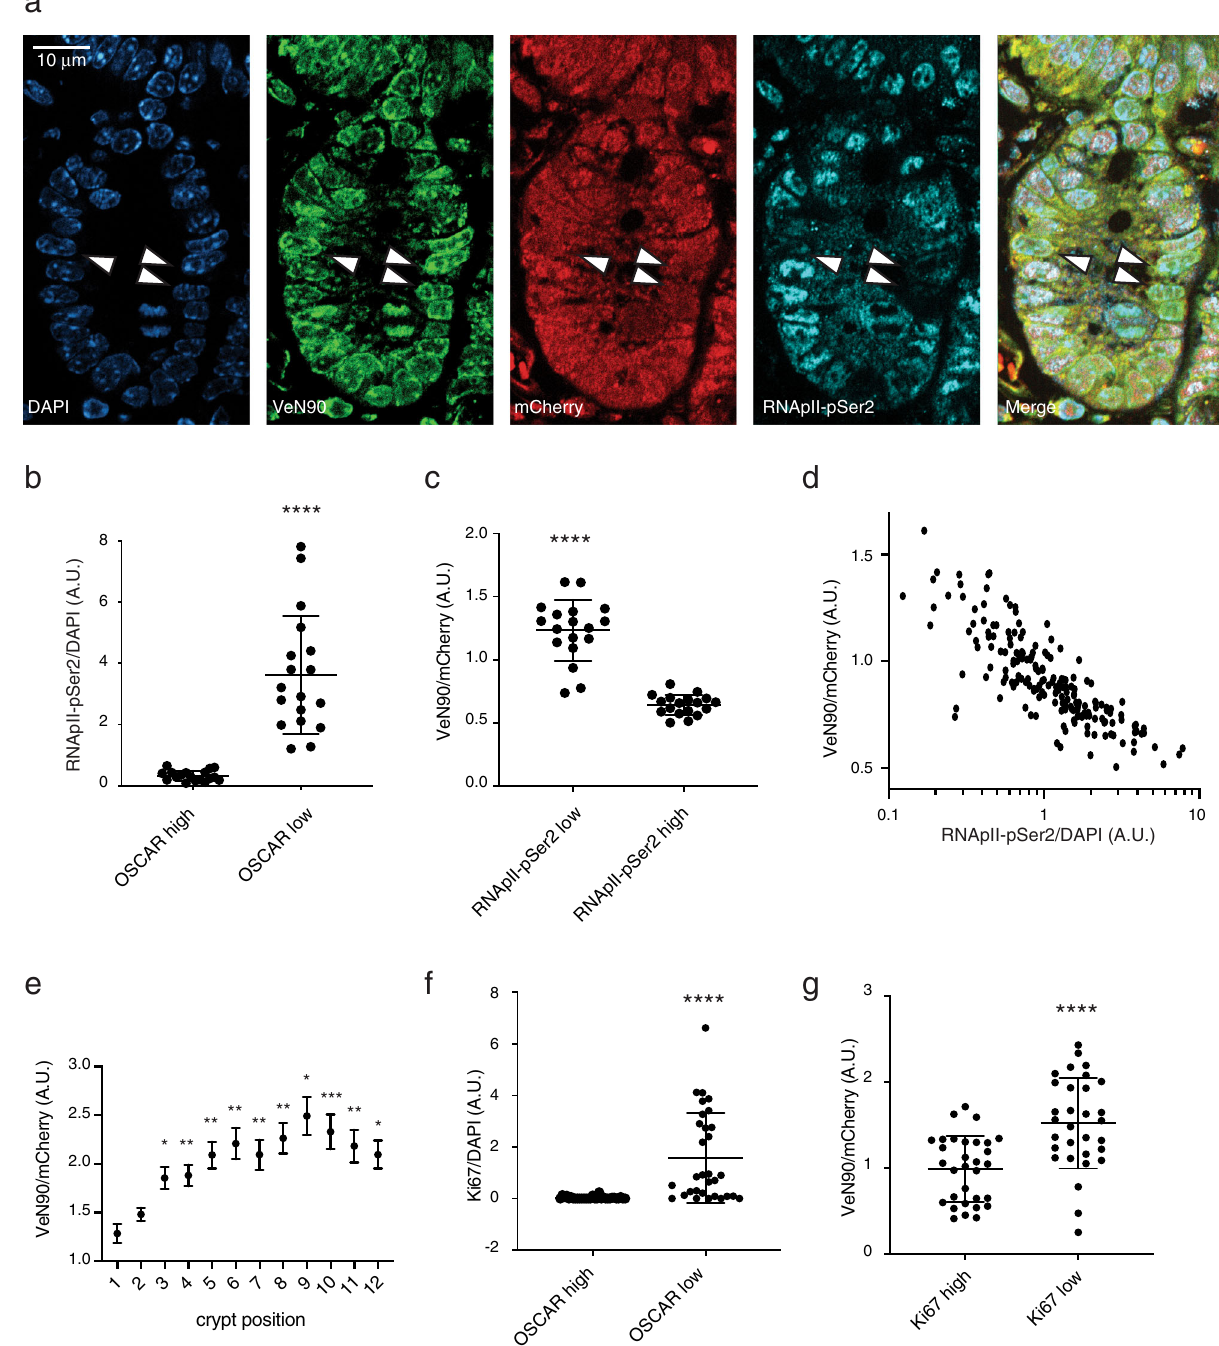
performed a geneset enrichment analysis by using different marker datasets of the major cell types in the intestinal epithelium (Fig. 5a) 39 . P4 and P5 populations showed a signi fi cant enrich- ment in ISC markers, while P1 population was signi fi cantly enriched in enterocyte markers (Fig. 5a). Interestingly, all the markers of fully differentiated secretory cells of the intestinal epithelium (Paneth, Goblet, Tuft, and enteroendocrine cells)